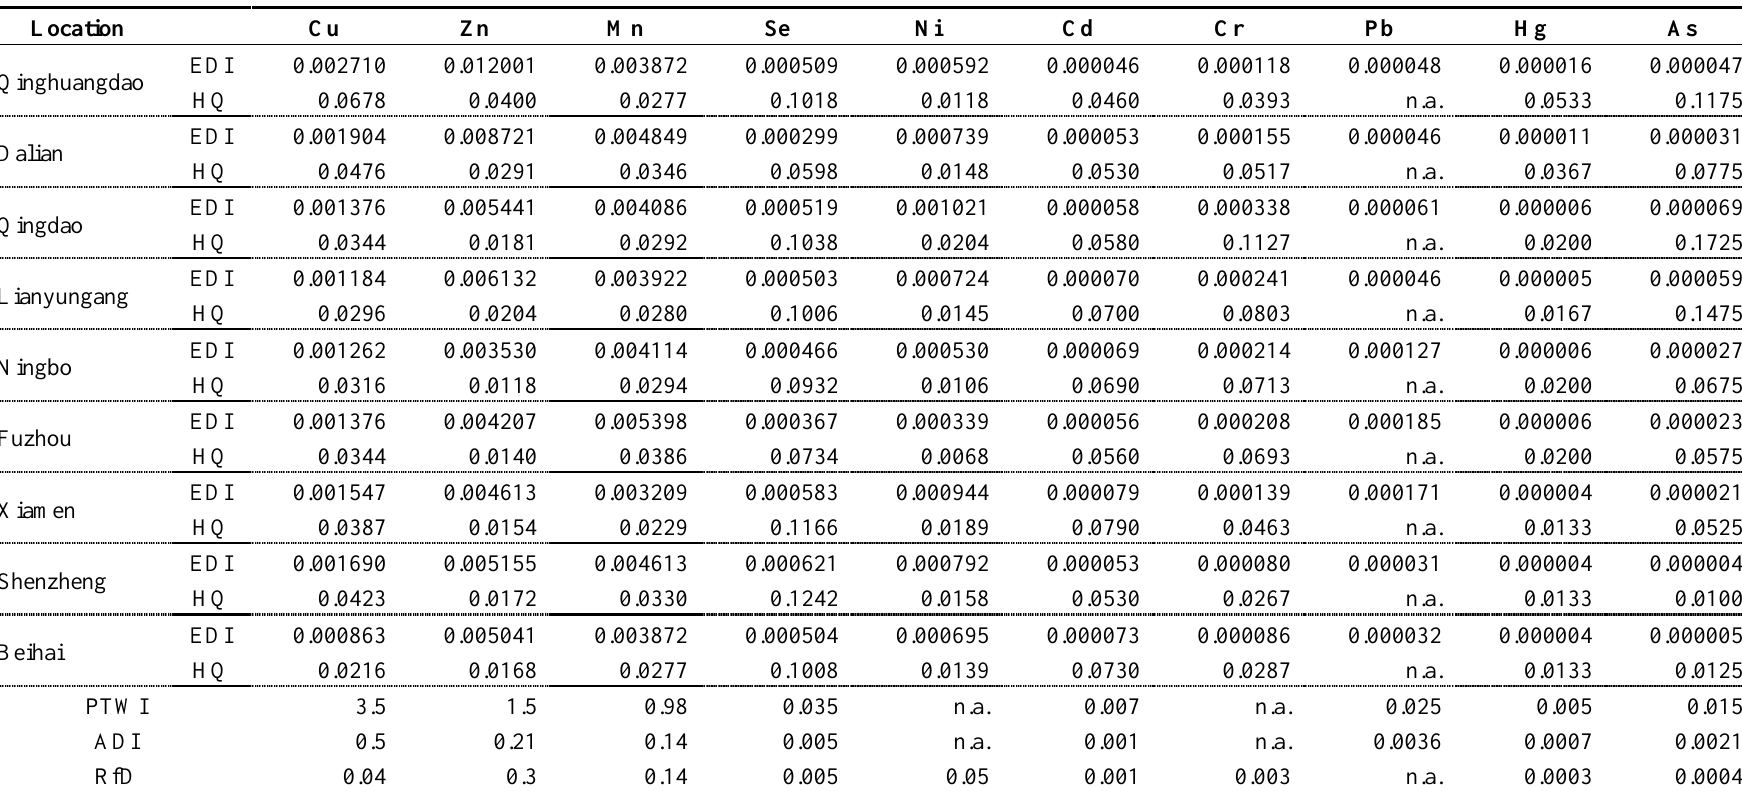
Table 1. Estimated daily intake (EDI) (mg·kg −1 bw·day −1 ) and hazard quotients (HQs) of trace elements through Ruditapes